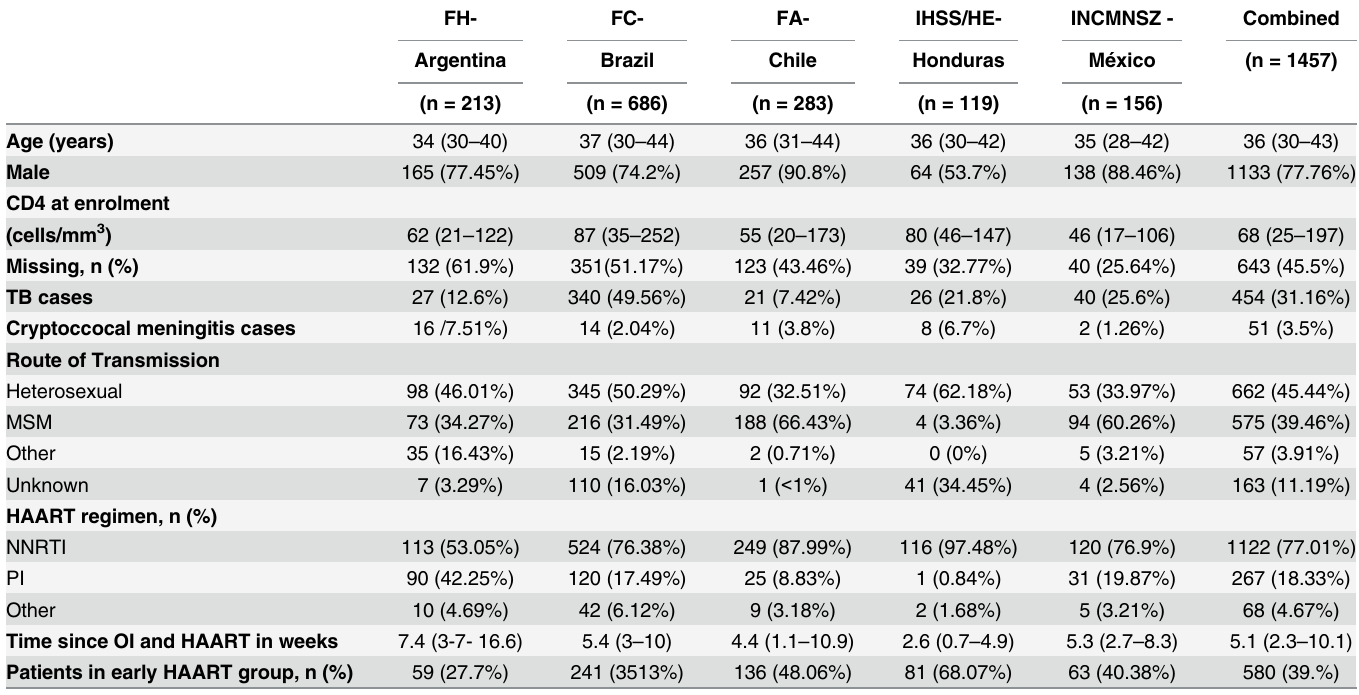
Table 1. Baseline patient characteristics according to site, and combined.